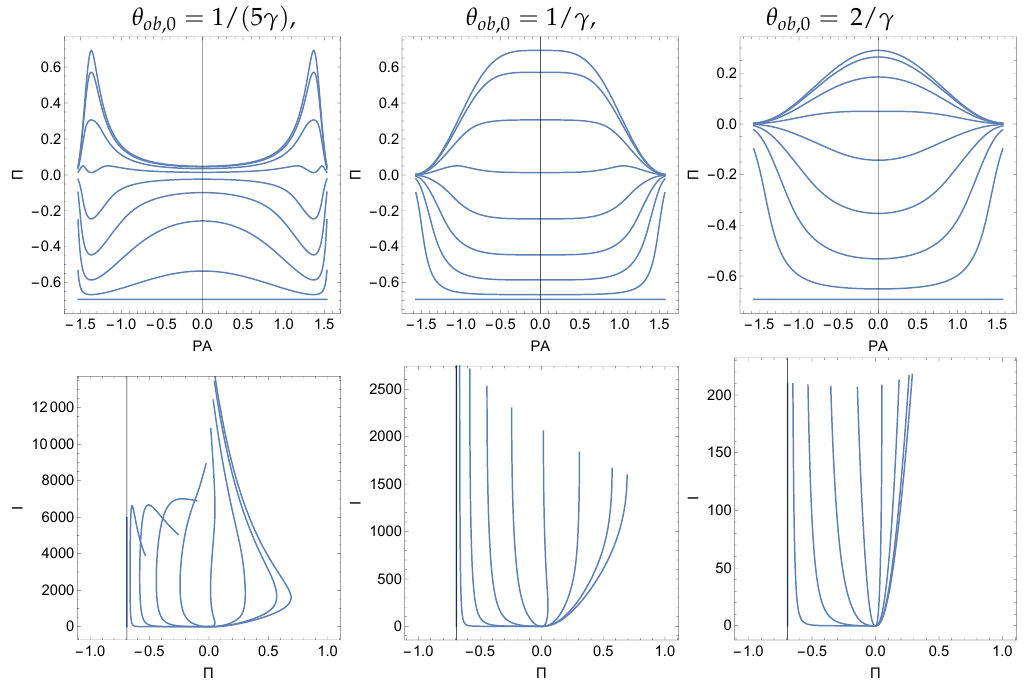
Figure 3. Same set-up as Figure 2. Top Row : Polarization Π as function of position angle. Bottom Row : Intensity as function of polarization degree Π